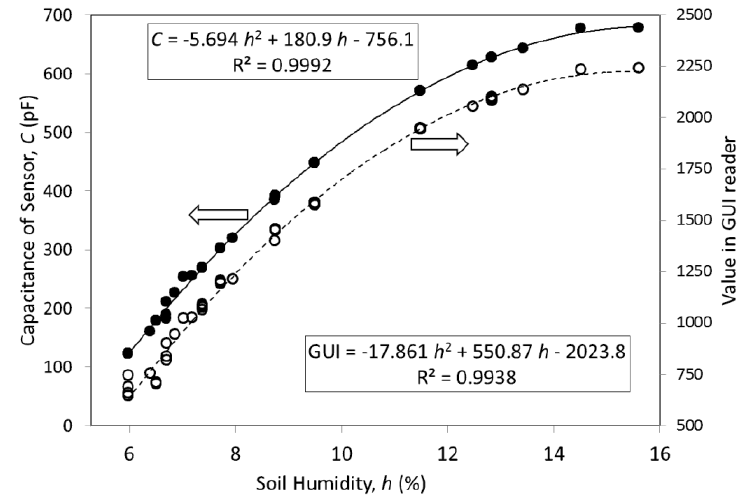
Figure 9. Sensor capacitance (solid dots and line) as a function of soil moisture h (weight ratio). Dashed line and hollow dots are values obtained by GUI of UHF RFID reader. Curves are parabolic approximations.